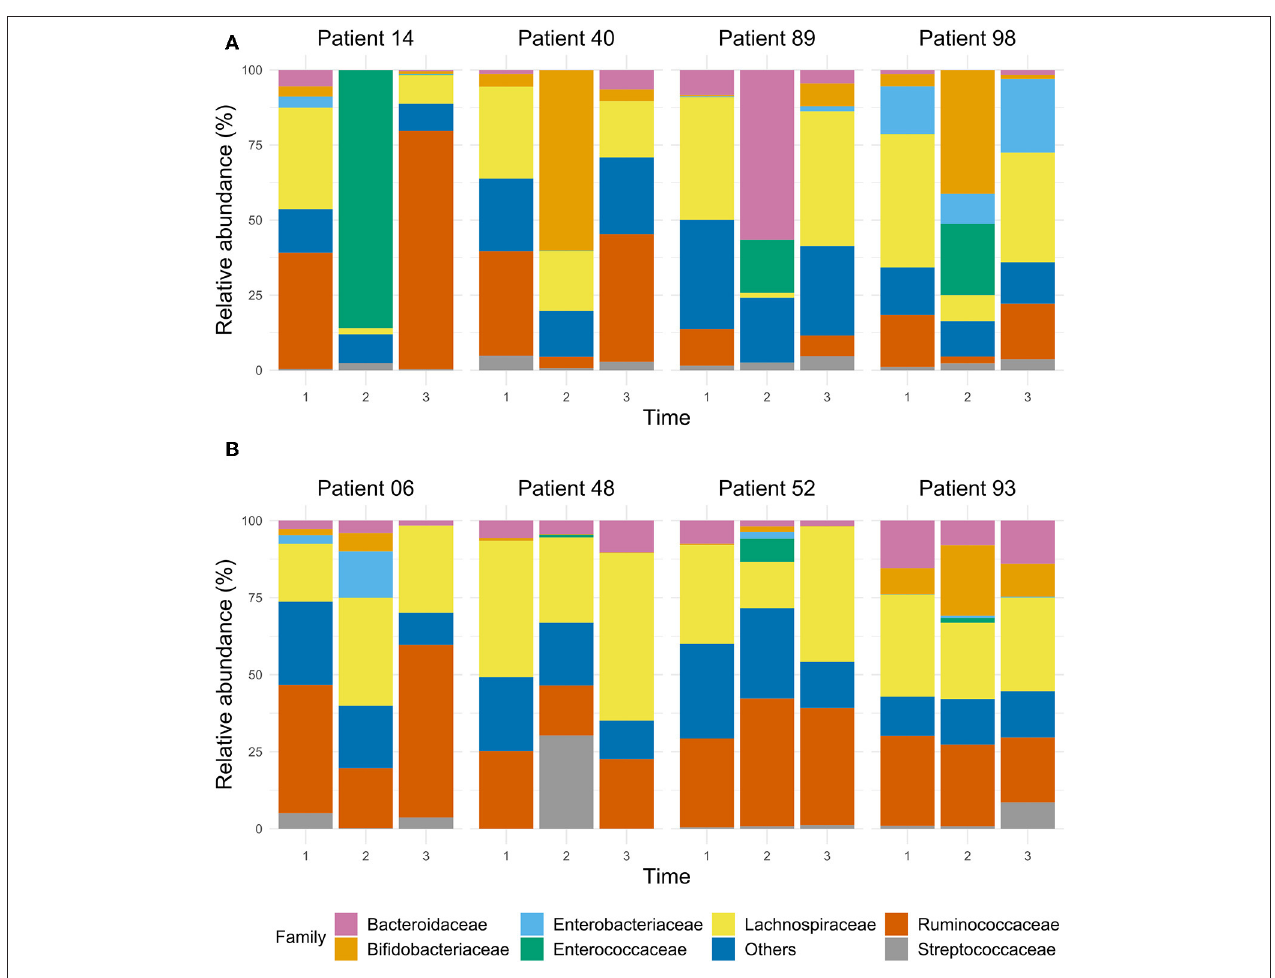
FIGURE 5 | The bar chart of selected samples represents the relative abundance of the main taxa, expressed at family level, in the gut microbiota of ICU patients whose microbiota dramatically decreased according to their Shannon index during the stay at the ICU (A) , and of ICU patients who had a stable Shannon index over time (B)